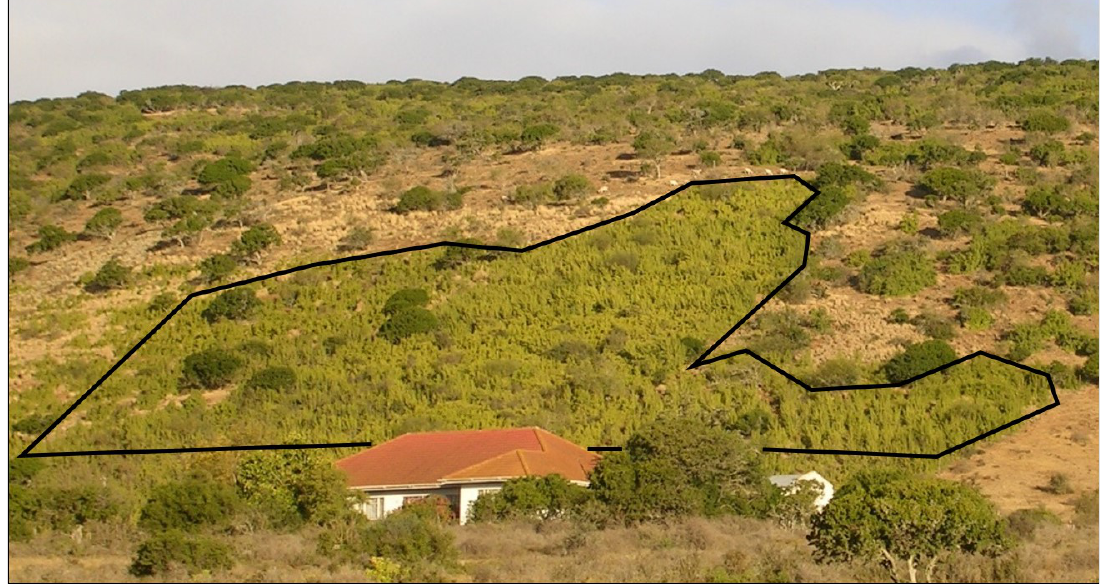
Figure 2. A degraded thicket hillslope that was, starting in the early 1970s, planted with spekboom cuttings over the course of three decades. Planted areas are those demarcated within the black lines. Location: Krompoort Farm, ~86 km SE of Steytlerville, Eastern Cape, South